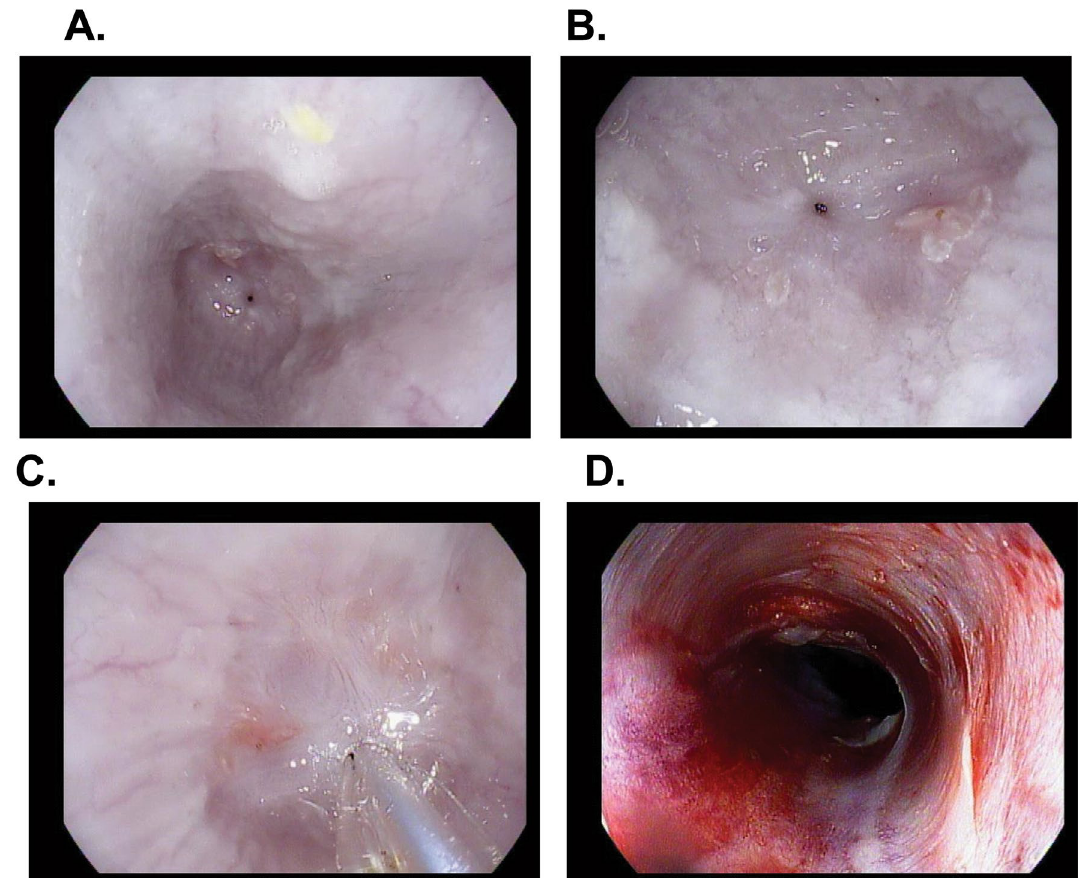
Figure 4. Endoscopic appearance of the esophageal strictures at day 28 (14 days after balloon dilation to 9 mm). ( A ) Appearance of a pinhole stricture (1 mm in diameter) with upstream dilation of the esophagus. ( B ) Appearance of the esophagus 2 cm proximal to the stricture. ( C ) The TTS balloon was advanced through the stricture and ready for dilation. ( D ) Appearance of the stricture after dilation to 9 mm. Note the tear encompassing 75% of the circumference of the esophageal lumen.